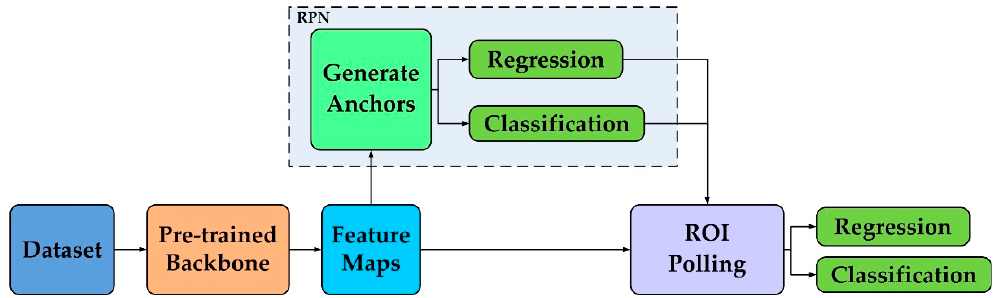
Figure 4. Few-shot PolSAR ship detection framework based on Faster R-CNN.